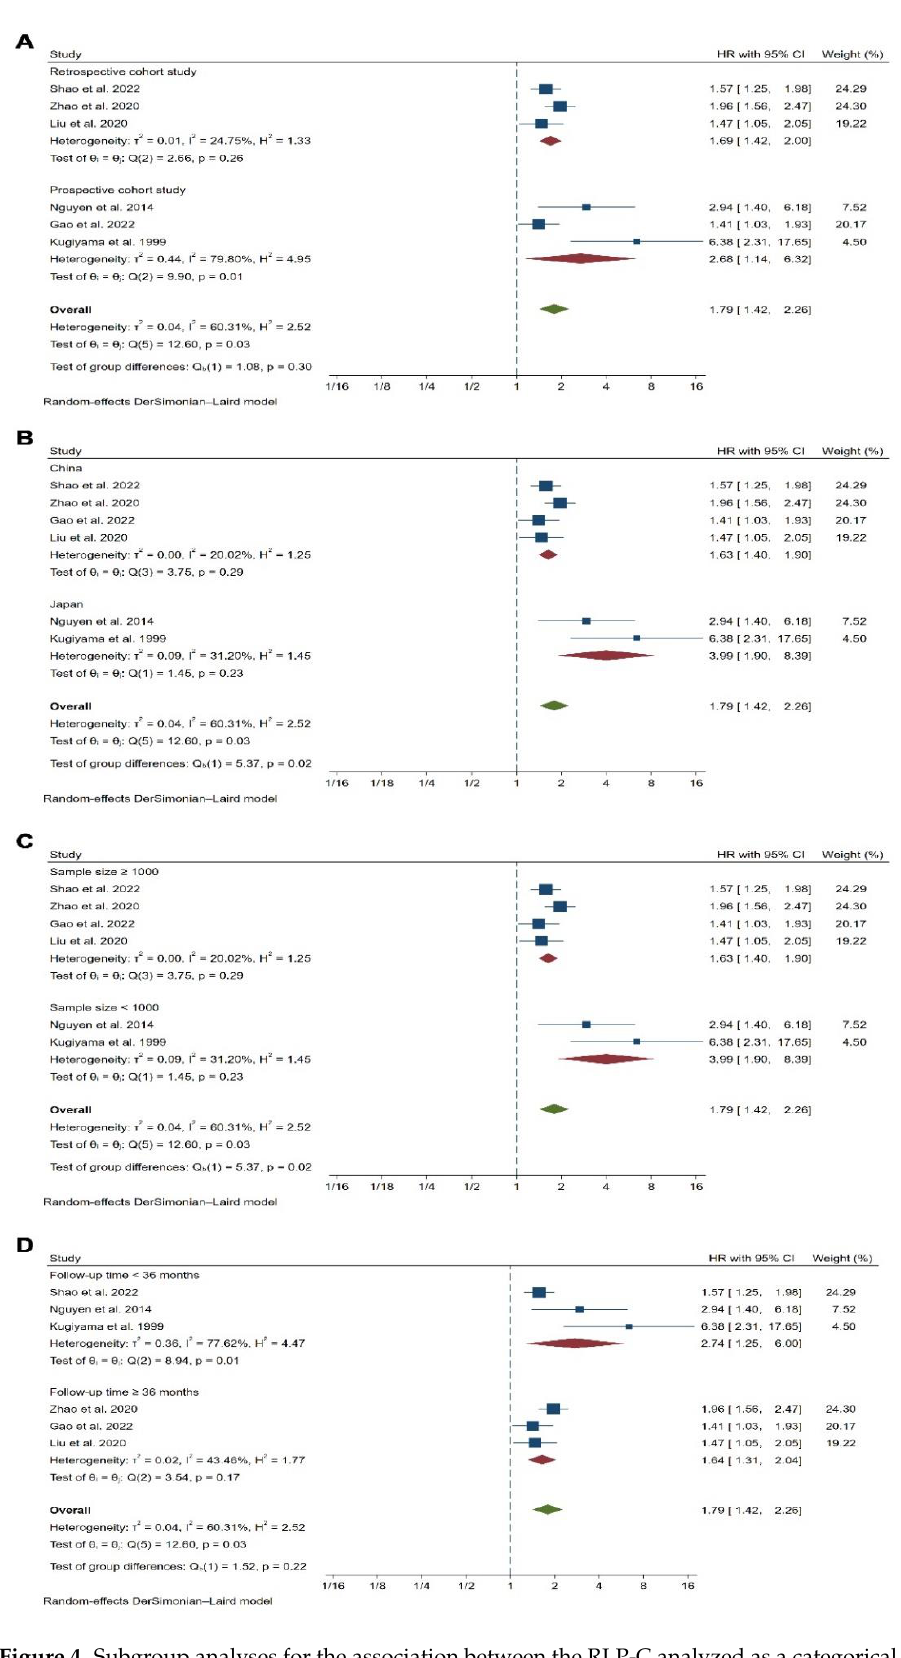
Figure 4. Subgroup analyses for the association between the RLP-C analyzed as a categorical variable and the risk of MACEs. ( A ) Subgroup analysis according to the study design. ( B ) Subgroup analysis according to the country of origin. ( C ) Subgroup analysis according to the sample size. ( D ) Subgroup analysis according to the follow-up time. References involved in the study: